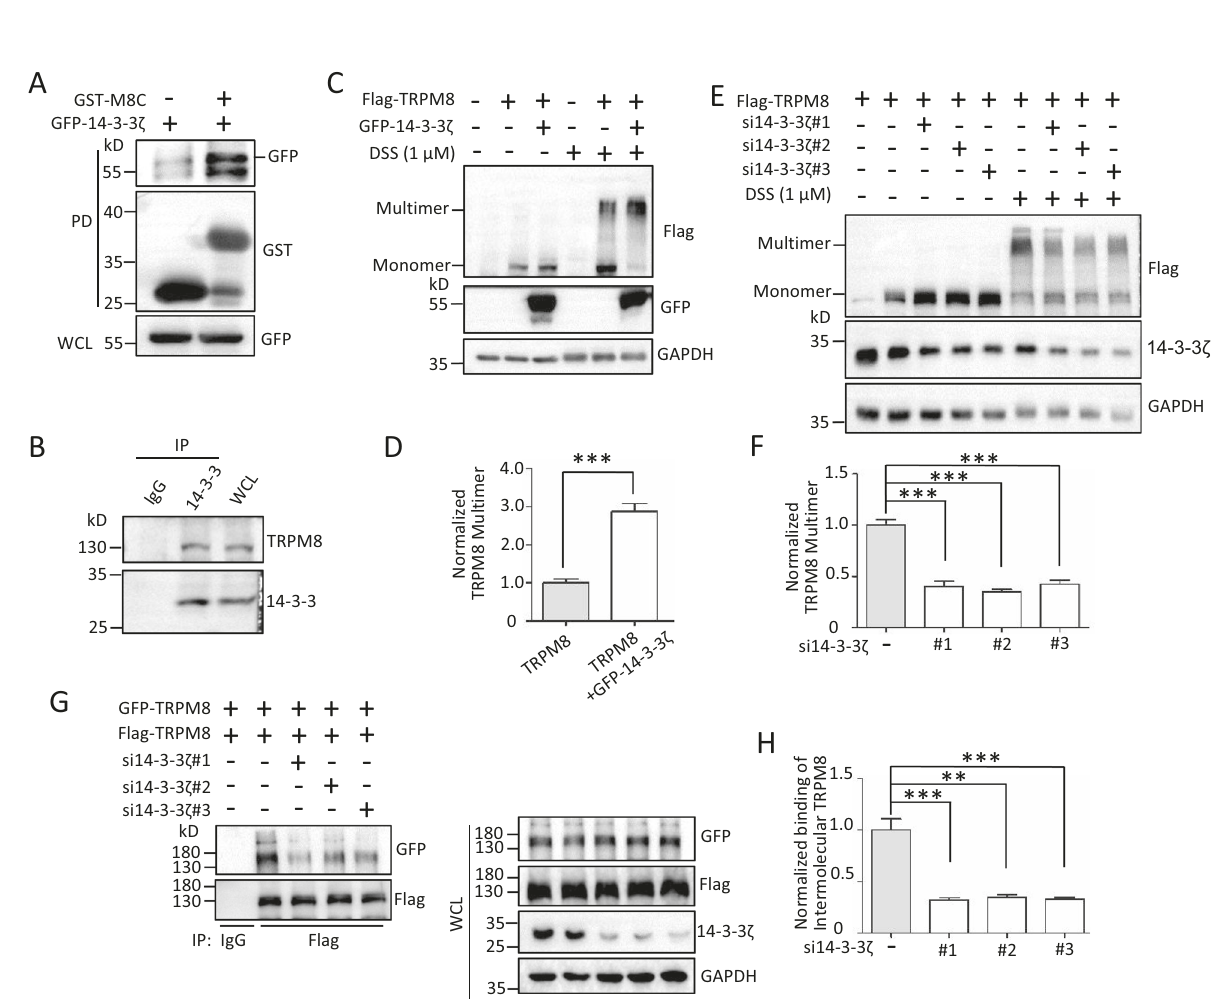
Fig. 5 14-3-3 ζ interaction with TRPM8 for regulating TRPM8 multimerization. A GST pull-down assay. Puri fi ed GST alone or GST-M8C fusion proteins expressed in E. coli BL21 bacteria were incubated with the lysates from HEK293T cells expressing GFP-14-3-3 ζ constructs and subjected to WB assay. B Co-IP assay. The lysates of native PANC-1 cells were added to an anti-14-3-3 antibody for IP and then subjected to WB assay with an anti-TRPM8 antibody. C , D Expression constructs for Flag-TRPM8 with or without GFP-14-3-3 ζ were transfected into PANC-1 cells, before harvest for treatment with 1 μ M DSS for 30 min. The lysates were subjected to WB assay with the indicated antibodies to detect the level of TRPM8 multimerization. E , F Similar experiments in ( C ) and ( D ) but cells co-expressing Flag-TRPM8 along with human 14-3-3 ζ -speci fi c siRNAs (si14-3-3 ζ #1, #2, or #3). G , H AsPC-1 cells were co-transfected Flag-TRPM8 and GFP-TRPM8 with or without si14-3-3 ζ , and then harvested for IP with an anti-Flag antibody and WB assay with the indicated antibodies to determine the binding of intermolecular TRPM8. ** P < 0.01, *** P < 0.001. Data are presented as mean ± SEM. All studies were repeated at least three times. 14-3-3 ζ knockdown effectively inhibited the binding of inter- suggesting that TRPM8 interacted with 14-3-3 ζ in a protein molecular TRPM8 in AsPC-1 cells (Fig. 5G, H), further supporting complex. Next, we determined the functional role of 14-3-3 ζ in the role of 14-3-3 ζ in TRPM8 multimerization. TRPM8 multimerization. The results showed that 14-3-3 ζ over- Based on the above fi ndings, we hypothesized that 14-3-3 ζ is expression or knockdown markedly enhanced or reduced TRPM8 involved in the regulation of TRPM8 multimerization by LCK. multimerization, respectively, in the presence of DSS (Fig. 5C – F). Cell Death and Disease (2022)